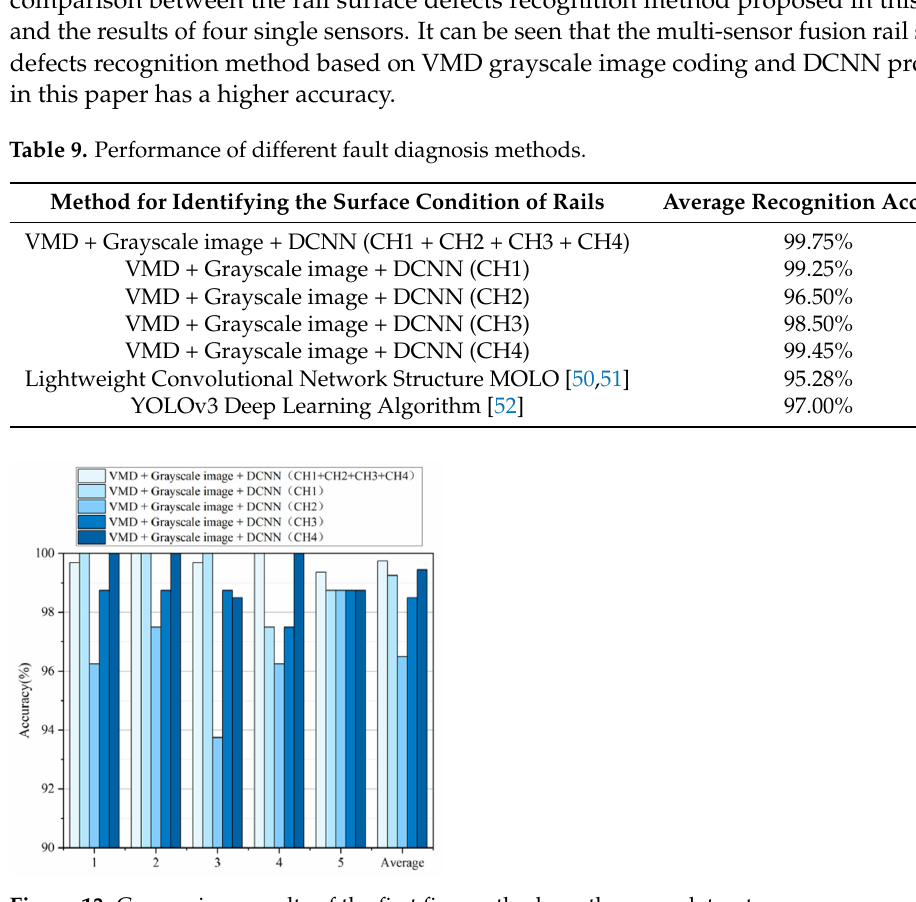
Figure 13. Comparison results of the first five methods on the same dataset.